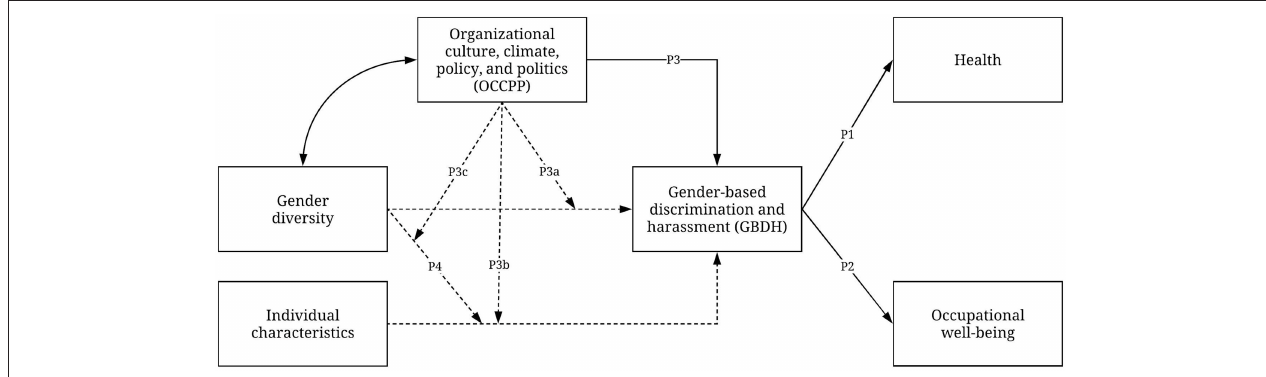
FIGURE 1 | Integrative model of GBDH in the workplace. Continuous paths represent direct relationships. Dashed paths represent fully moderated relationships. The double-ended arrow signals the relationship between gender diversity and OCCPP, which follows a circular causation